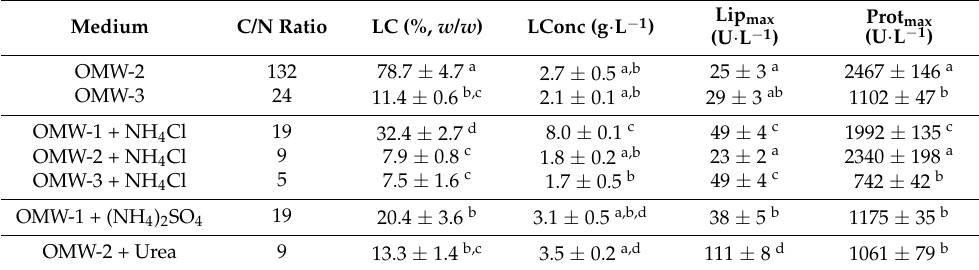
Table 5. Lipid content (LC), lipid concentration (LConc), and maximum activity of lipase (Lip max ) and protease (Prot max ) obtained in C. tropicalis ATCC 750 batch cultures carried out in Erlenmeyer flasks with and without the addition of an external nitrogen source. Data are the average ± standard deviation of two independent replicates. Values followed by the same letter in each column do not present statistically significant differences ( p ≤